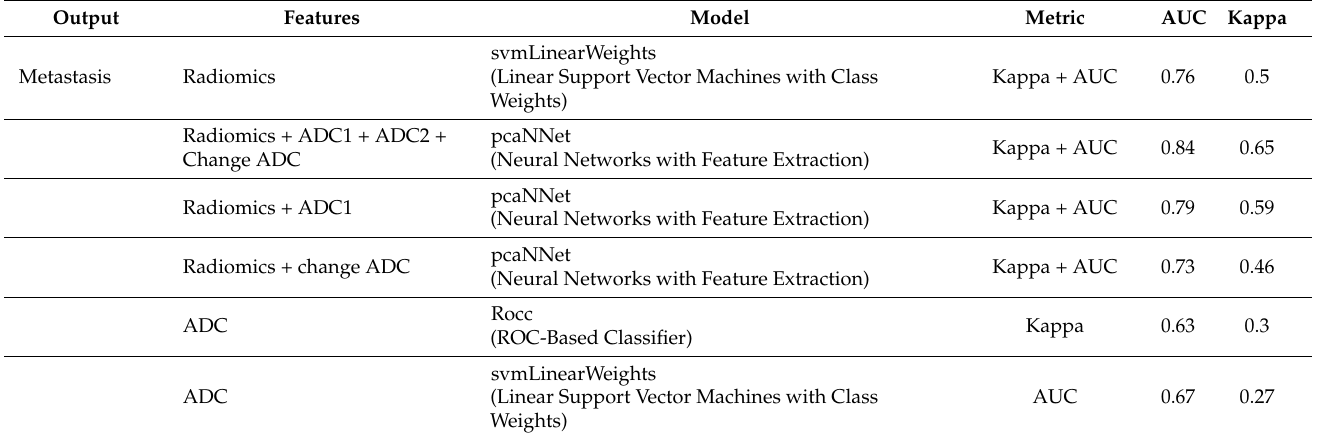
Table 3. Tabulated content of metastasis with relevant classifier algorithm and corresponding AUC with Kappa values. Output